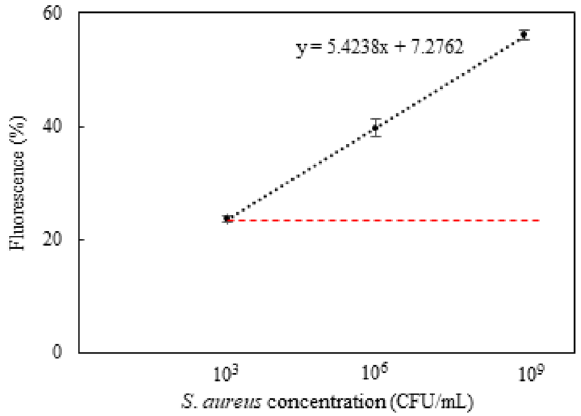
Figure 7. Fluorescence percentage (%) calculated by the smartphone app versus S. aureus concentration of LAMP assay with the cut-off (red dotted